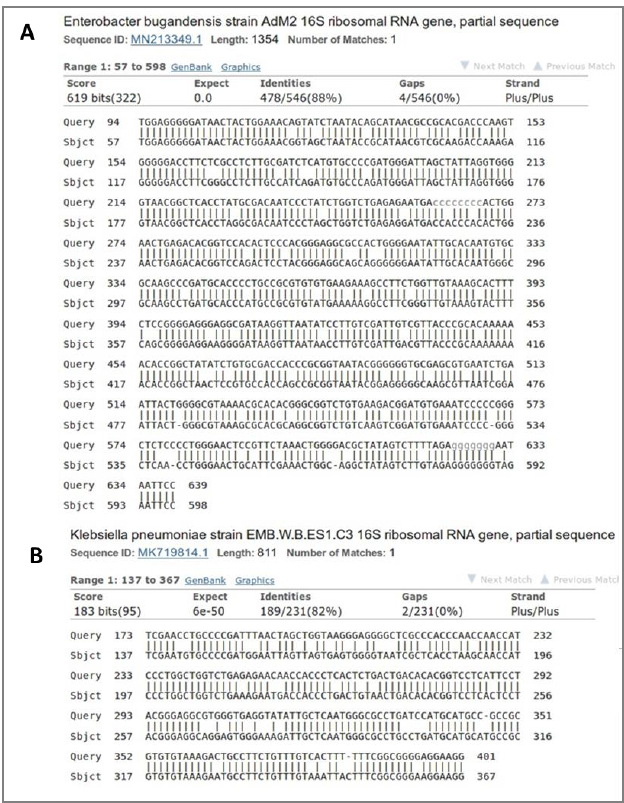
Figure 2 : The BLAST results of 16S bacterial sequences obtained in the current